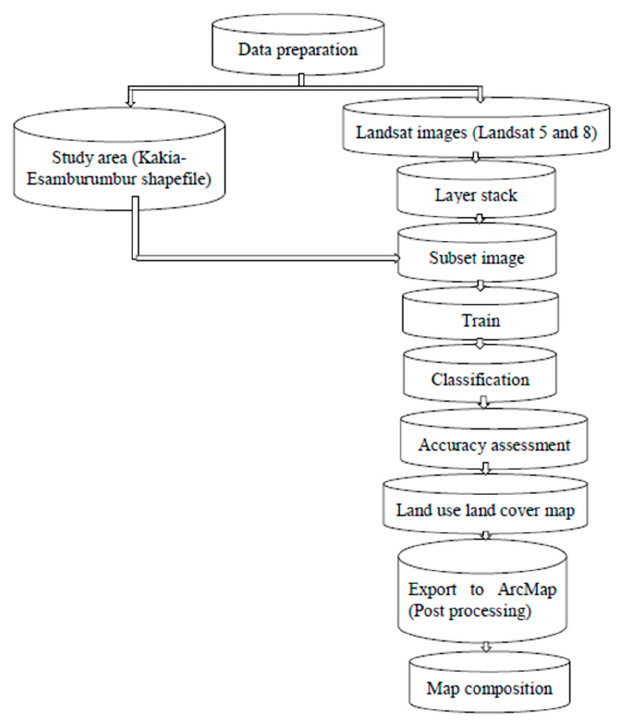
Figure 2. Data analysis flowchart.